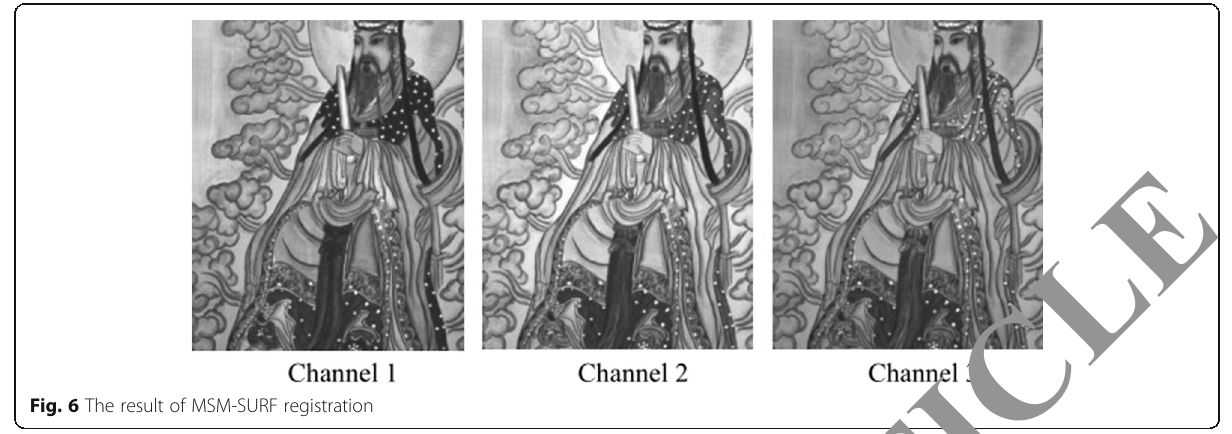
Fig. 6 The result of MSM-SURF registration